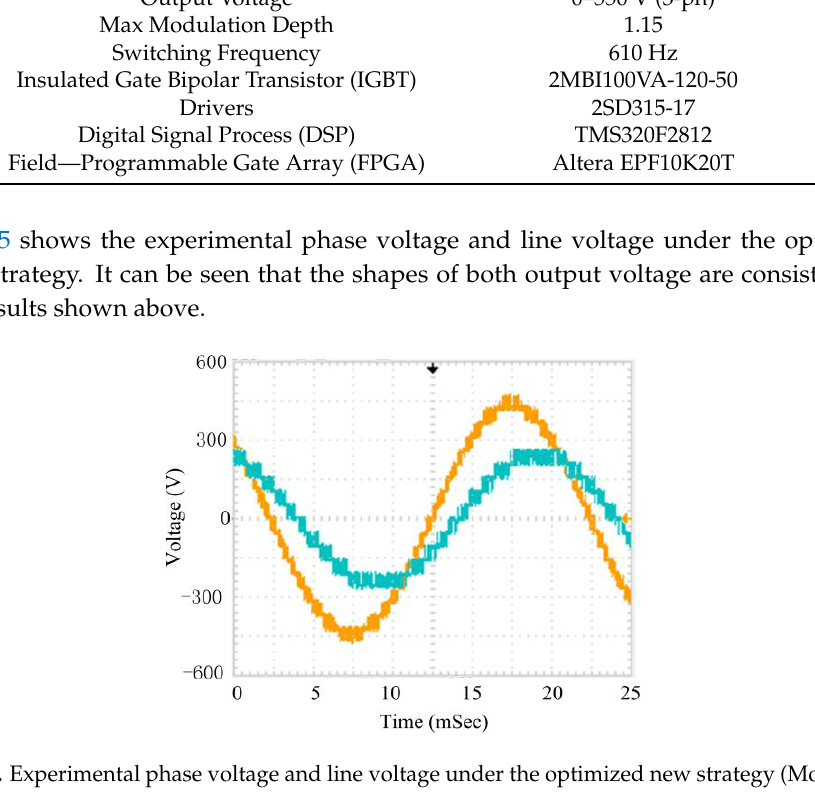
Figure 15. Experimental phase voltage and line voltage under the optimized new strategy (Modulation depth, M = 0.95).